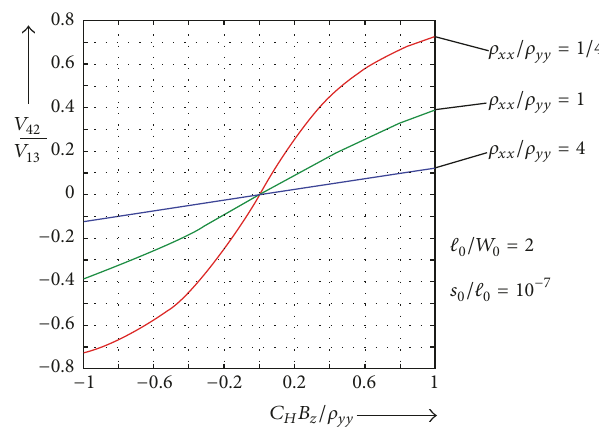
Figure 20: Output voltage over supply voltage of a Hall plate from Figure 19 with two squares input resistance and point-sized output contacts as obtained by a finite element simulation with COMSOL MULTIPHYSICS. The strong anisotropy of the conductivity tensor is obtained by large stress 𝜎 𝑥𝑥 = −𝜎 𝑦𝑦 = ±4.41176 GPa in low n- doped silicon. The curves match with respective curves 1 (for 𝛾 = 0 ) in Figure 3 of [47]. The slopes of the curves in the weak field limit agree with the analytical theory of the present work (see Table